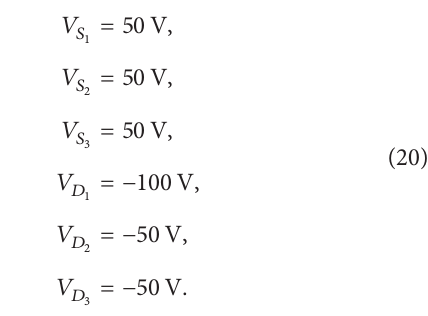
Figure 4: Steady state waveforms of the proposed converter.